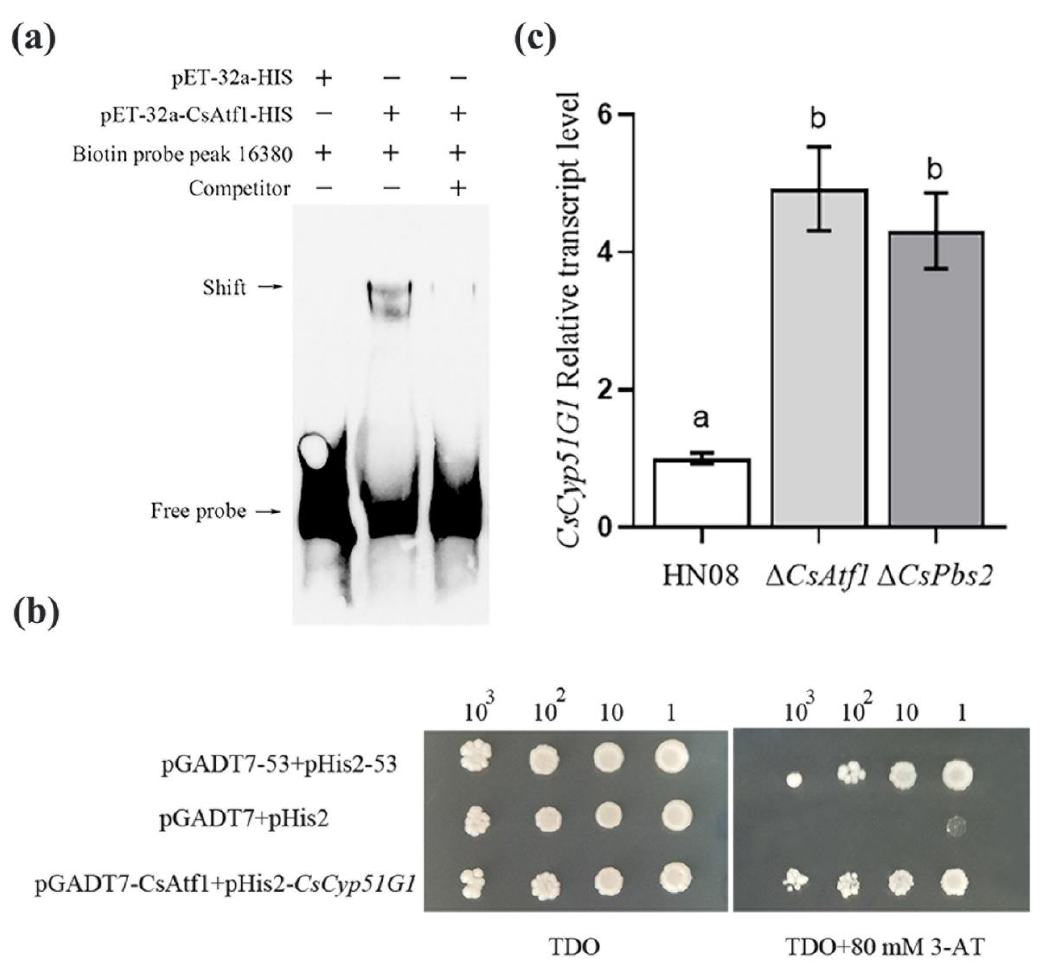
Figure 4. Analysis of the binding and expression relationship between CsAtf1 and CsCyp51G1 . ( a ) Detection of the binding relationship between the CsAtf1 protein and the promoter regions of CsCyp51G1 by EMSA. +, protein added, − , protein not added. ( b ) Y1H Gold confirmed that the transcription factor CsAtf1 binds to the promoter of CsCyp51G1 . The representative growth status of different cell culture dilutions (1:1, 1:10, 1:100, 1:1000) on SD/-Leu/-Trp/-His agar medium without and with 80 mM 3-AT is shown. ( c ) Relative expression analysis of CsCyp51G1 in the wild-type HN08, ∆ CsPbs2 , and ∆ CsAtf1 strains. Different letters (a, b) represent significant difference at p < 0.01 (One-way ANOVA and Duncan’s test).